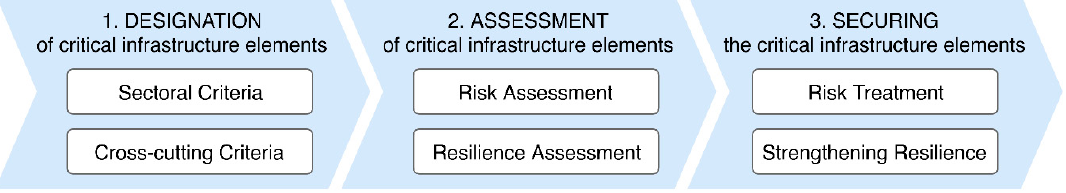
Figure 1. Critical infrastructure element protection management process (Rehak et al. 2018a).